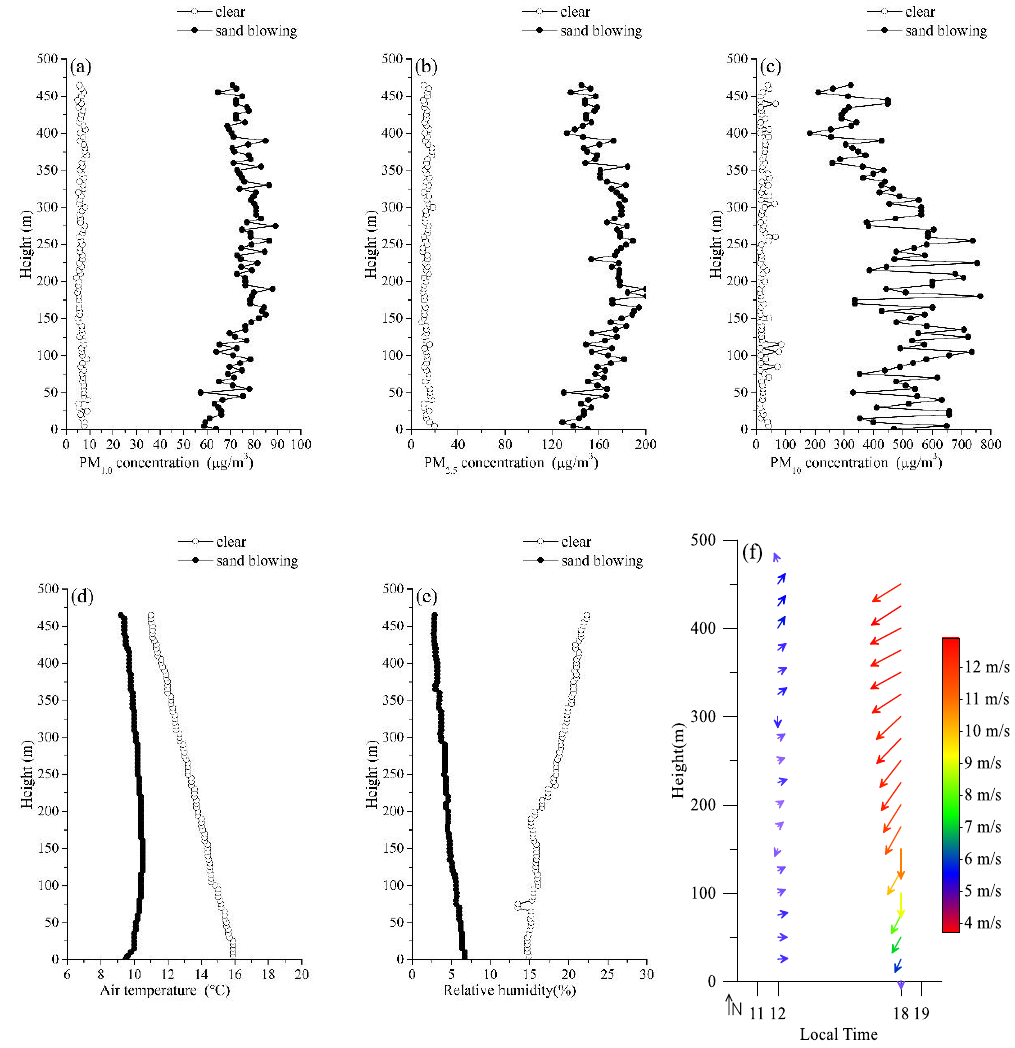
Figure 12. Vertical profiles of the PM concentrations ( a : PM 1.0 , b : PM 2.5 , and c : PM 10 ) and the related meteorological parameters ( d : air temperature, e : relative humidity, and f : vector wind) in the boundary layer on a clear period (12:00 local time, 8 November) and sand blowing period (18:00 local time, 11 November) at Tazhong.